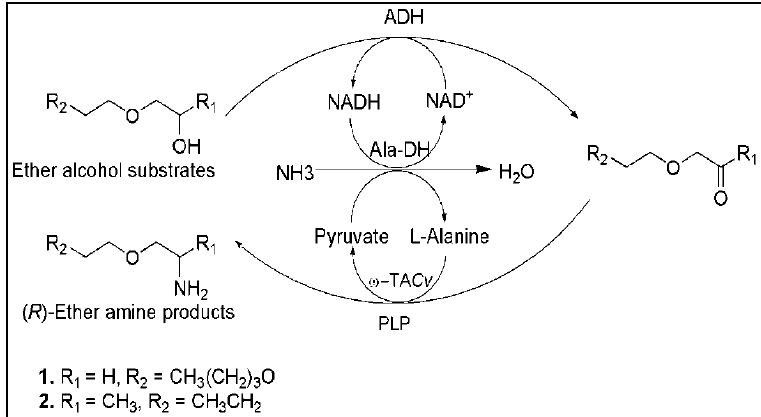
Figure 7. Artificial redox-neutral cascade employing alcohol dehydrogenase, ω -TA and alanine dehydrogenase for the synthesis of ether amines from ether alcohol substrates (reprinted from [115] with the permission of John Wiley and Sons). (Reaction conditions: 10 mM substrate, 280 mM ammonia, ammonium carbamate buffer (40 mM, pH 9.0), 1 mM NAD + , 0.35 mM PLP, 0.5 mM L -Alanine, 0.1 mg/mL ADH, 0.004 mg/mL Ala-DH, 0.064 mg/mL ω -TA Cv , 30 °C).